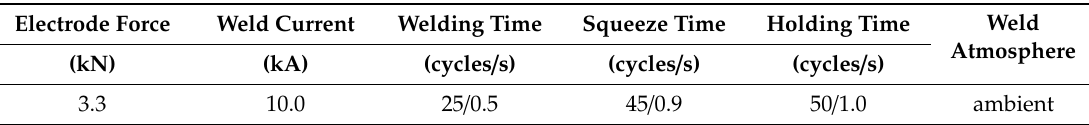
Table 6. Optimal welding condition.